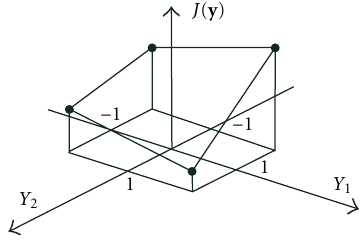
Figure 1: Two-dimensional Lyapunov